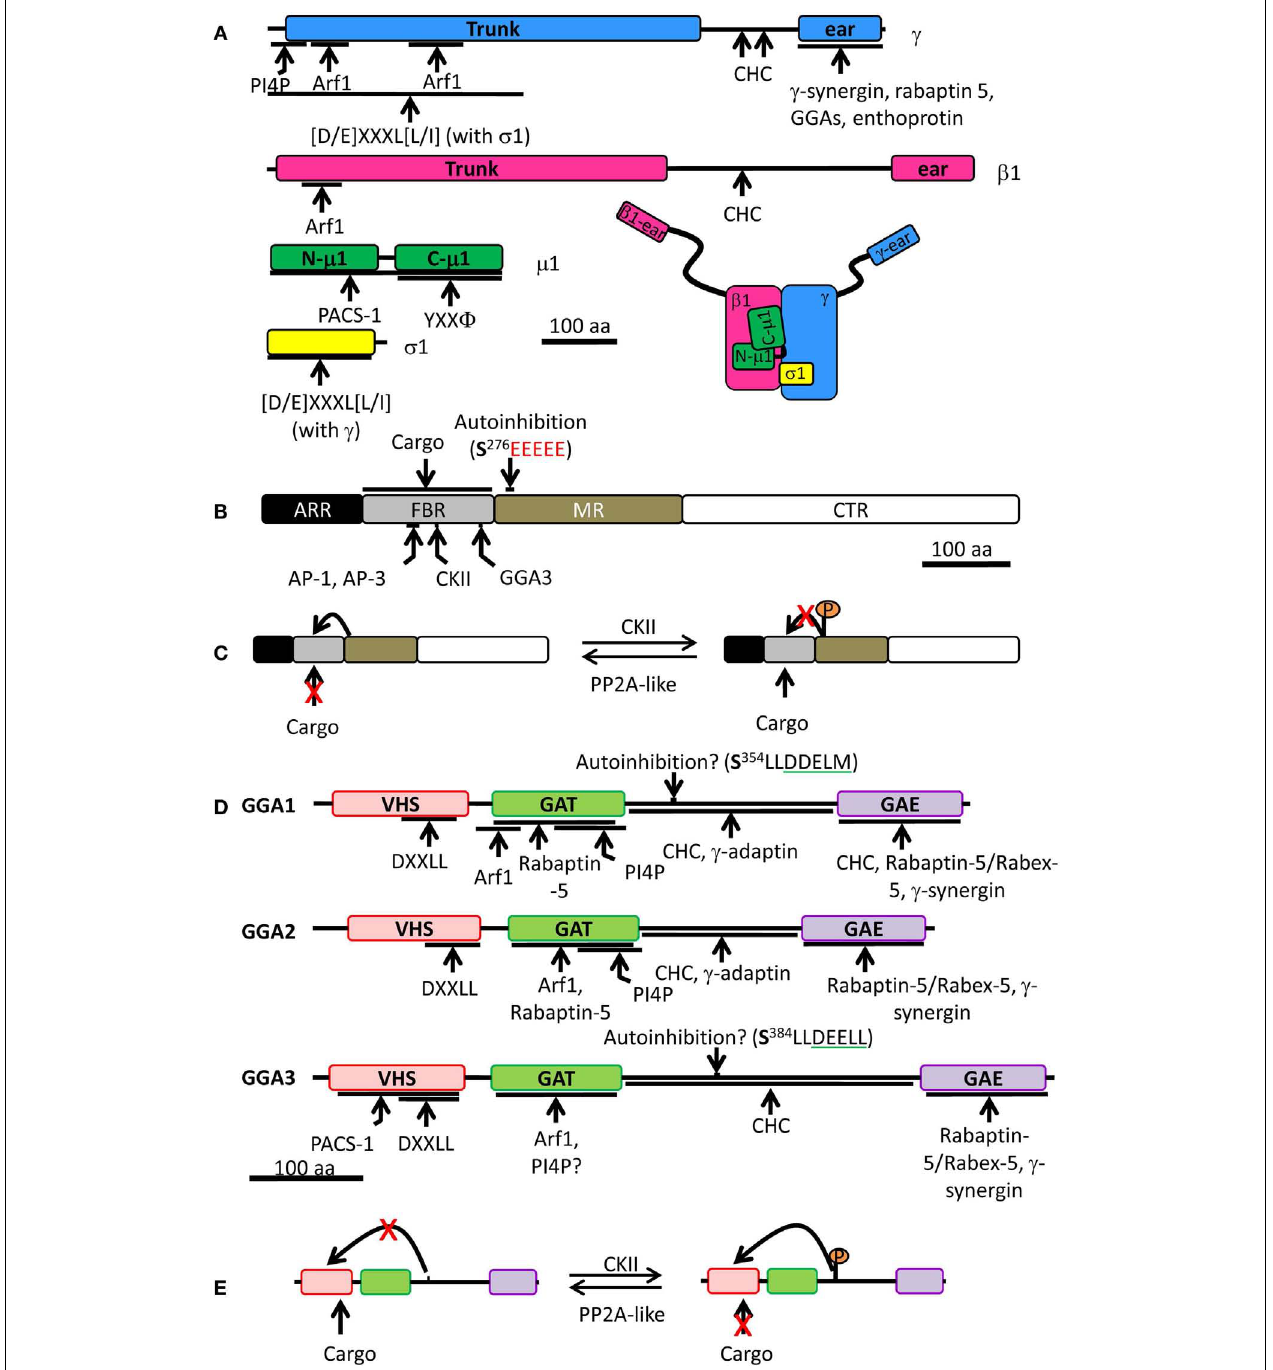
in red), along with the CKII binding site in the FBR. AP-1 and AP-3 interact with the same site in the FBR while GGA3 interacts with a different site.The FBR is also responsible for interactions with cargo. (C) Autoinhibition mechanism: the autoinhibition domain binds FBR, preventing PACS-1 interaction with cargo.When CKII phosphorylates Ser 276 of the autoinhibition domain, it inhibits the internal binding and promotes cargo interaction with PACS-1. PP2A, protein phosphatase 2A. (D) Each GGA is composed of four domains: VHS (pink), GAT (green), hinge (bar), and GAE (purple). Regulatory domain